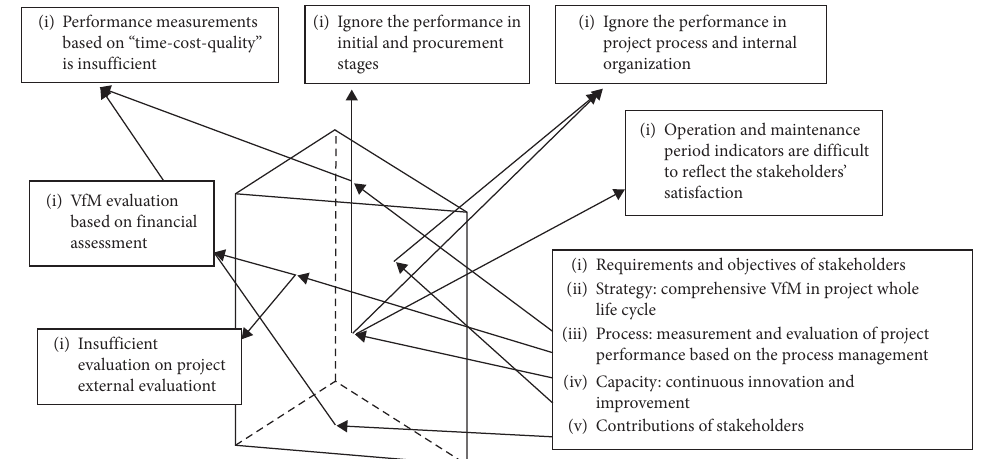
Figure 1: The performance prism of urban rail transit PPP Table 2: Performance evaluation indicator system during operation and maintenance period. Dimension Performance evaluation indicators during operation and maintenance period